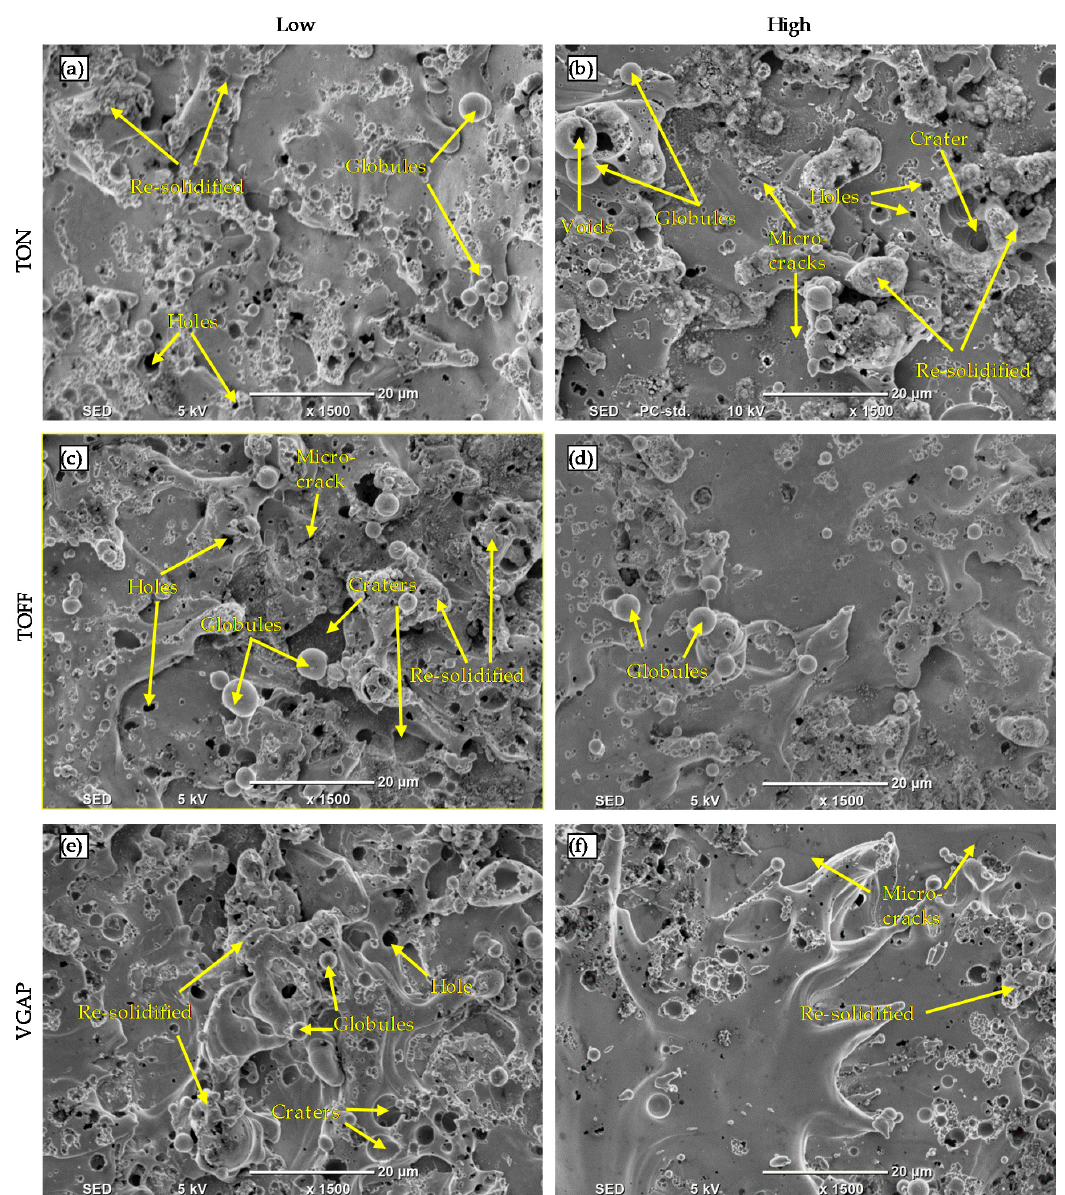
Figure 10. SEM images of WEDM machined surfaces at ( a ) low TON (1 MU) ( b ) high TON (9 MU) ( c ) low TOF (1 MU) ( d ) high TOF (9 MU) ( e ) low VGAP (35 V) ( f ) high VGAP (75 V).